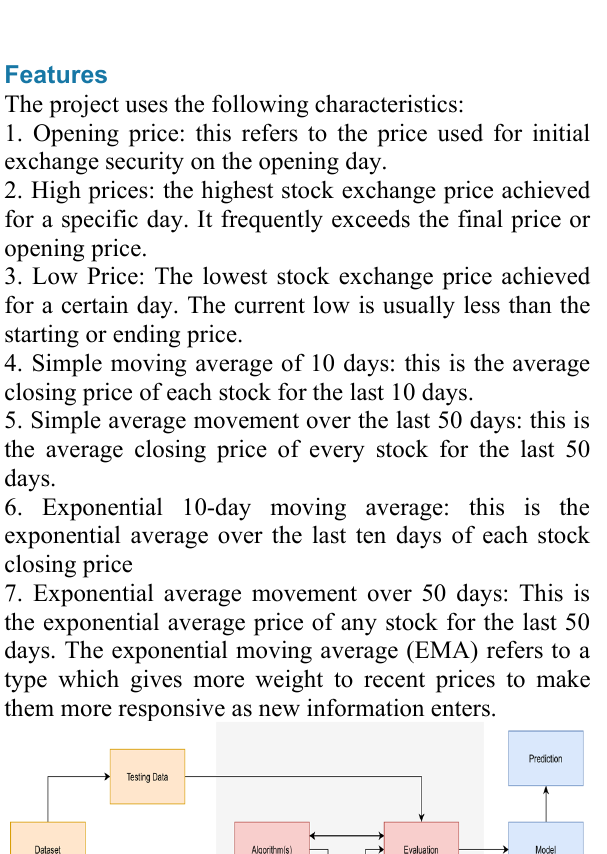
Figure 3. Flowchart for LSTM Prediction model for KSE Market